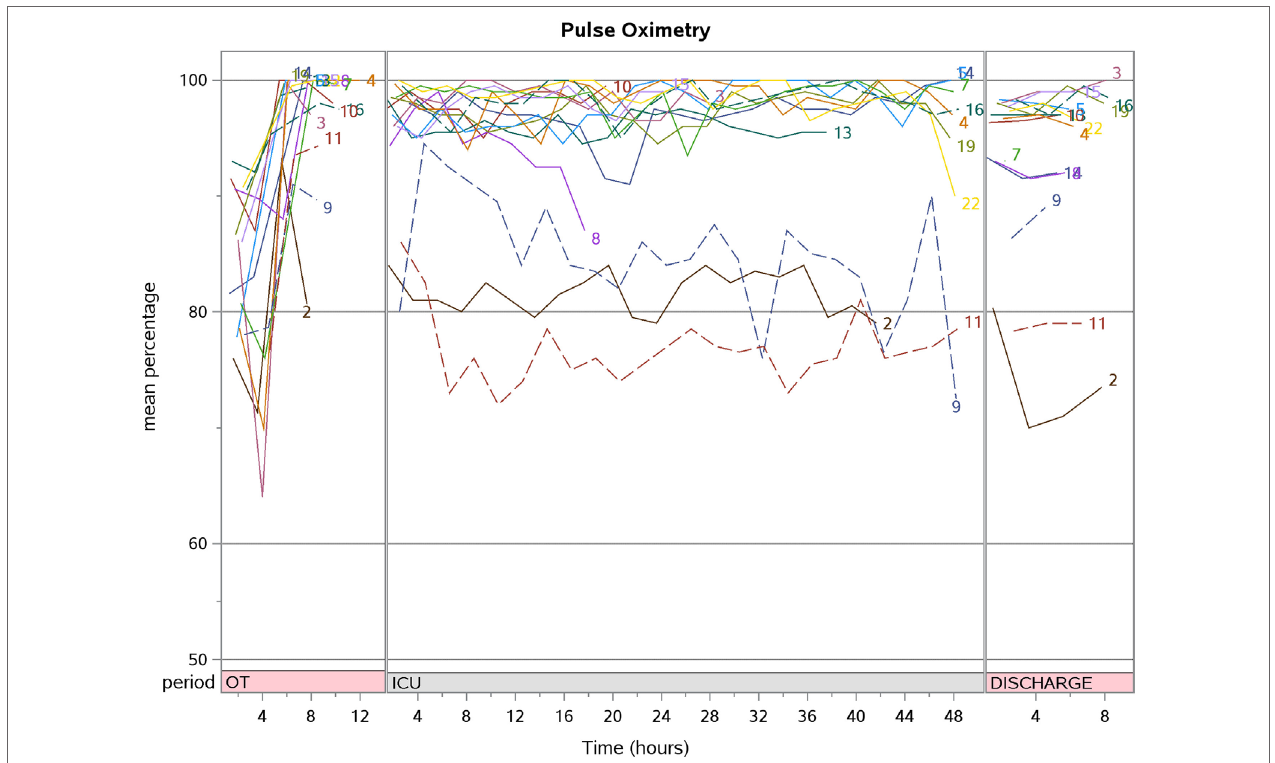
FigUre 4 | The aggregate pulse oximetry trend for patients who underwent corrective surgery ( N =